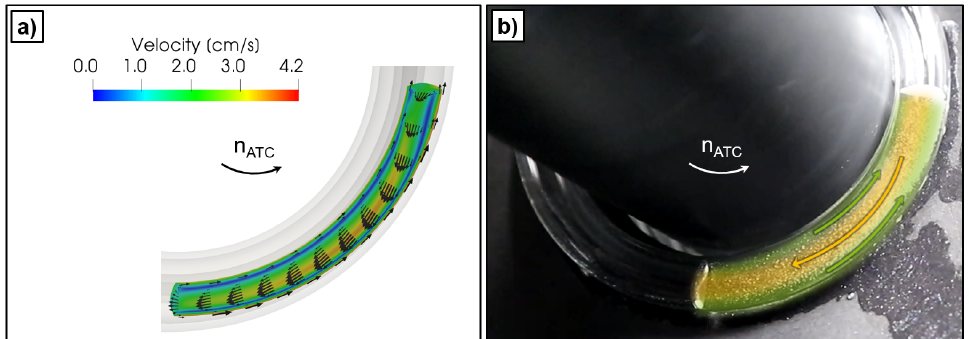
Figure 5. Hydrodynamics at exemplary operating point n ATC = 12min − 1 and (cid:101) = 0.25 in panel ( a ) CFD simulation and ( b ) experiment with Mica powder. The corresponding video for panel ( b ) is supplied in the Supplementary